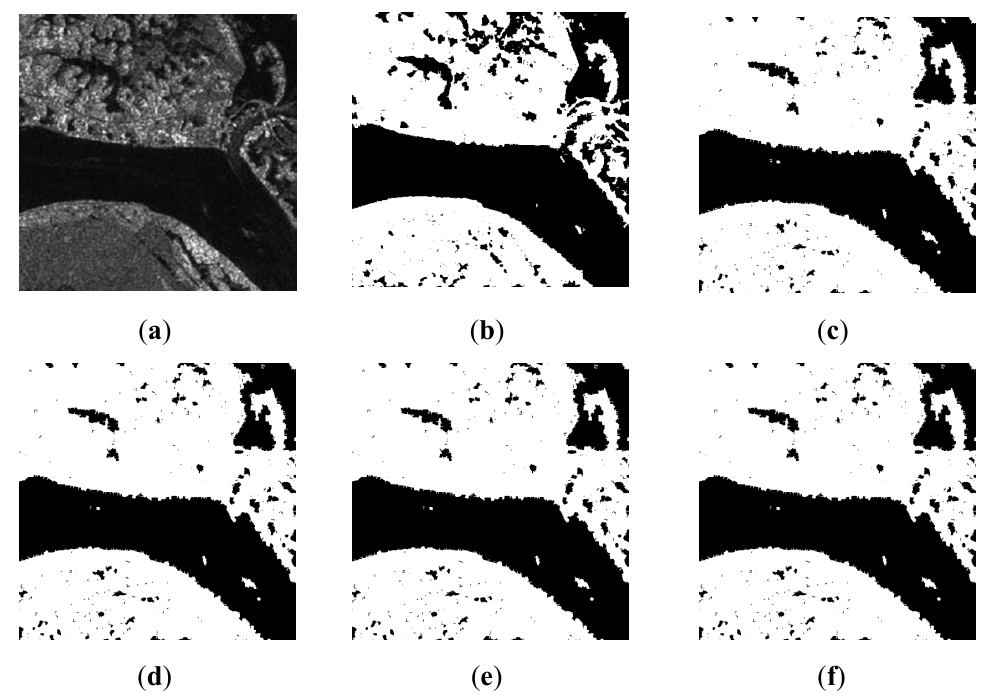
Figure 11. Segmentation results on SAR2. ( a ) original image; ( b ) AFWDLMO; ( c )